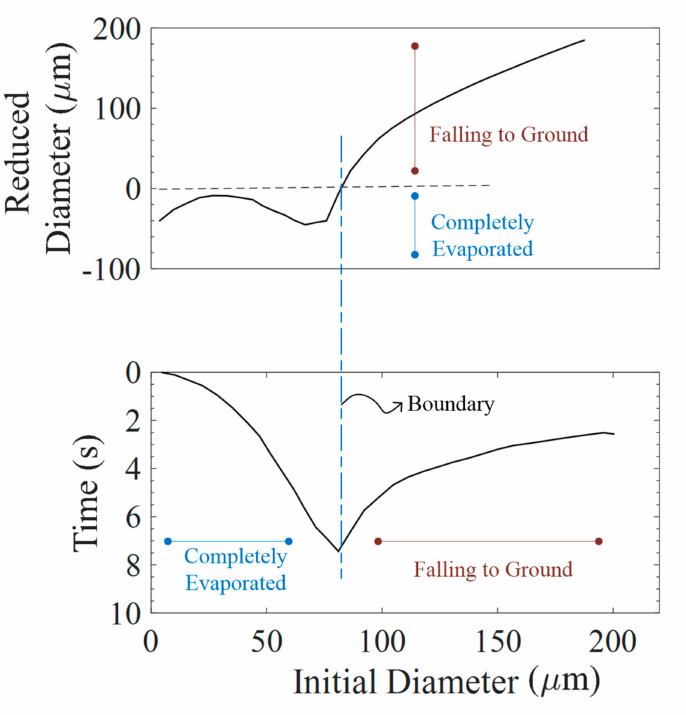
Figure 10. The region for the completely evaporated droplets and falling to the ground droplet after falling from 2 m